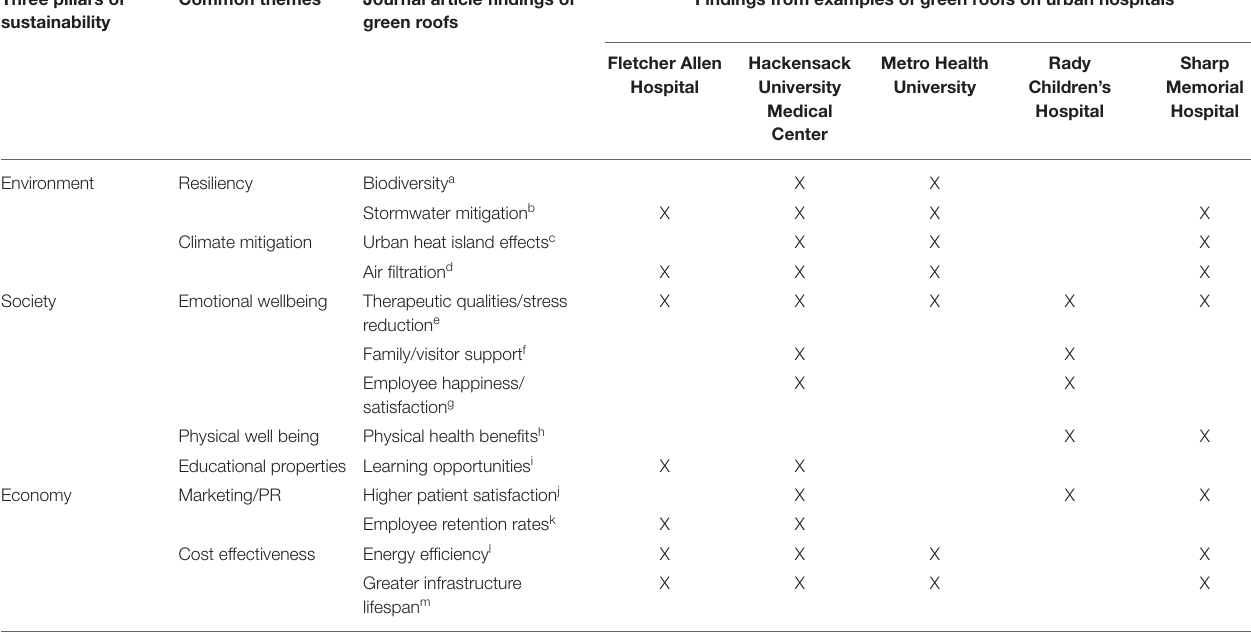
TABLE 2 | The three pillars of sustainability, comparing the findings from example hospitals and the journal articles. Three pillars of